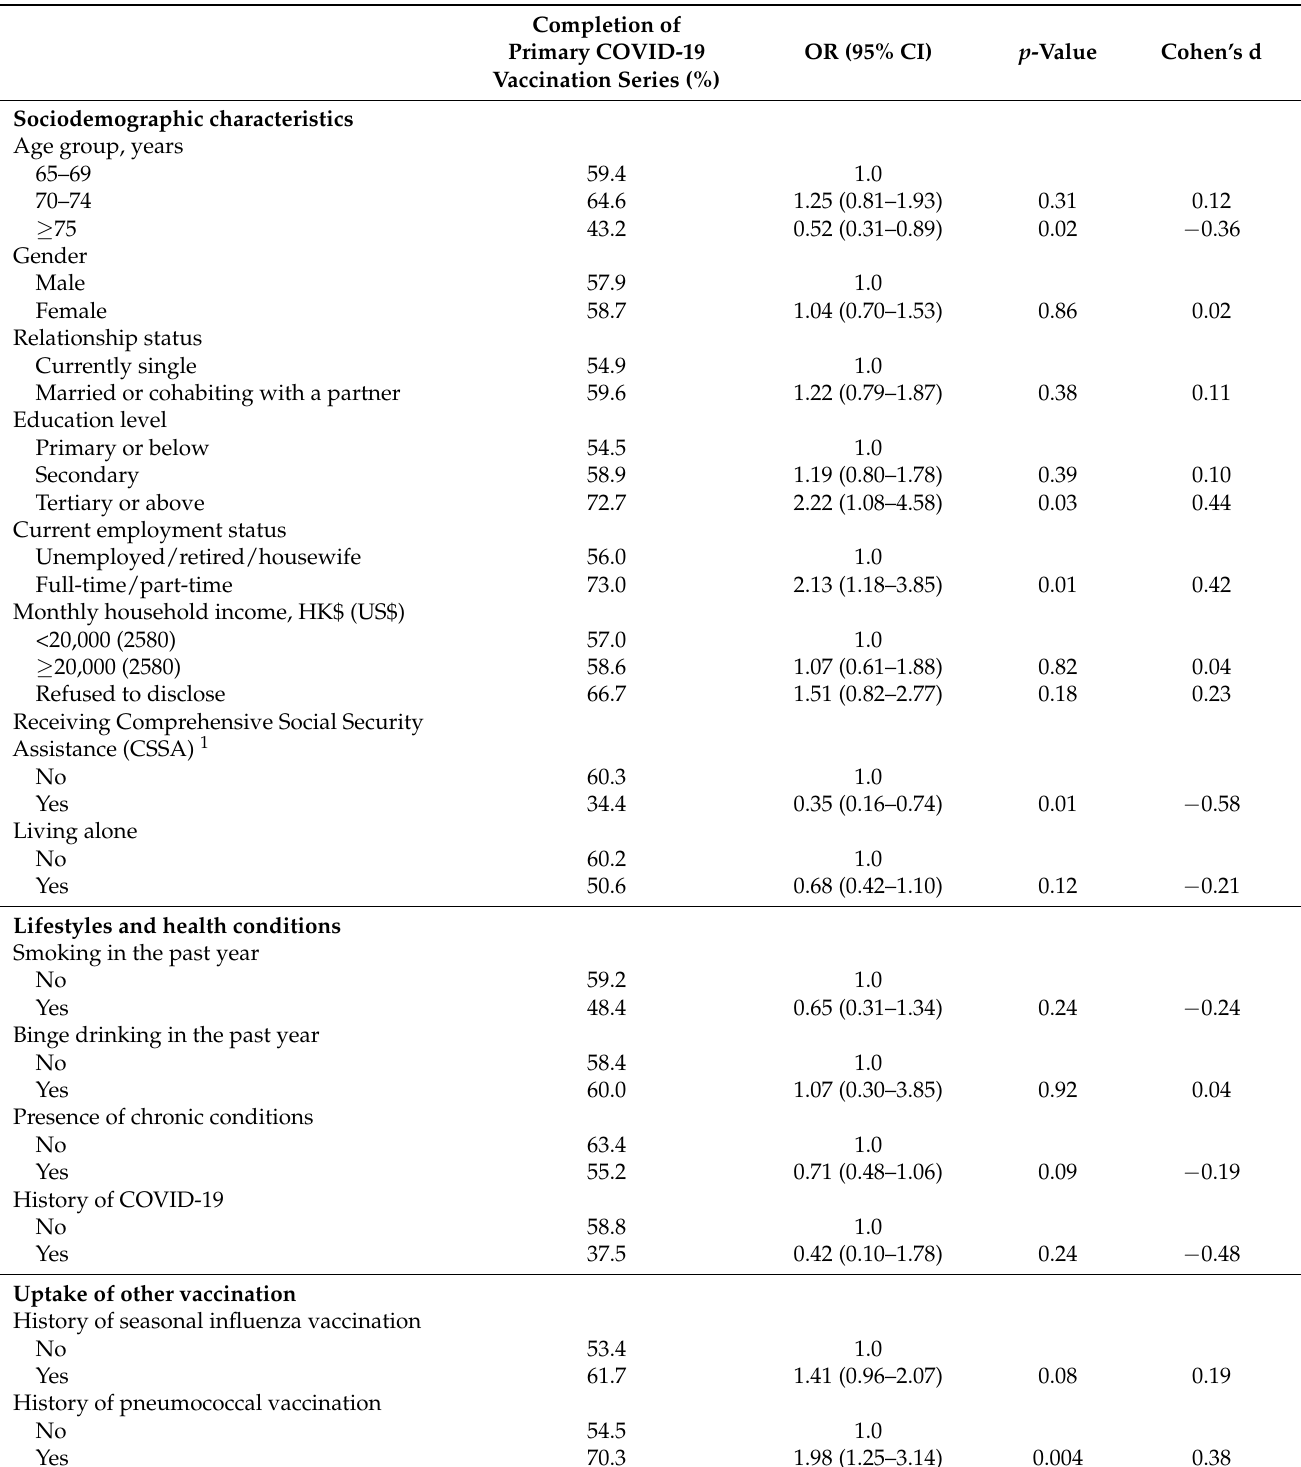
Table 3. Associations between background characteristics and completion of primary COVID-19 vaccination series among older adults in Hong Kong (n =